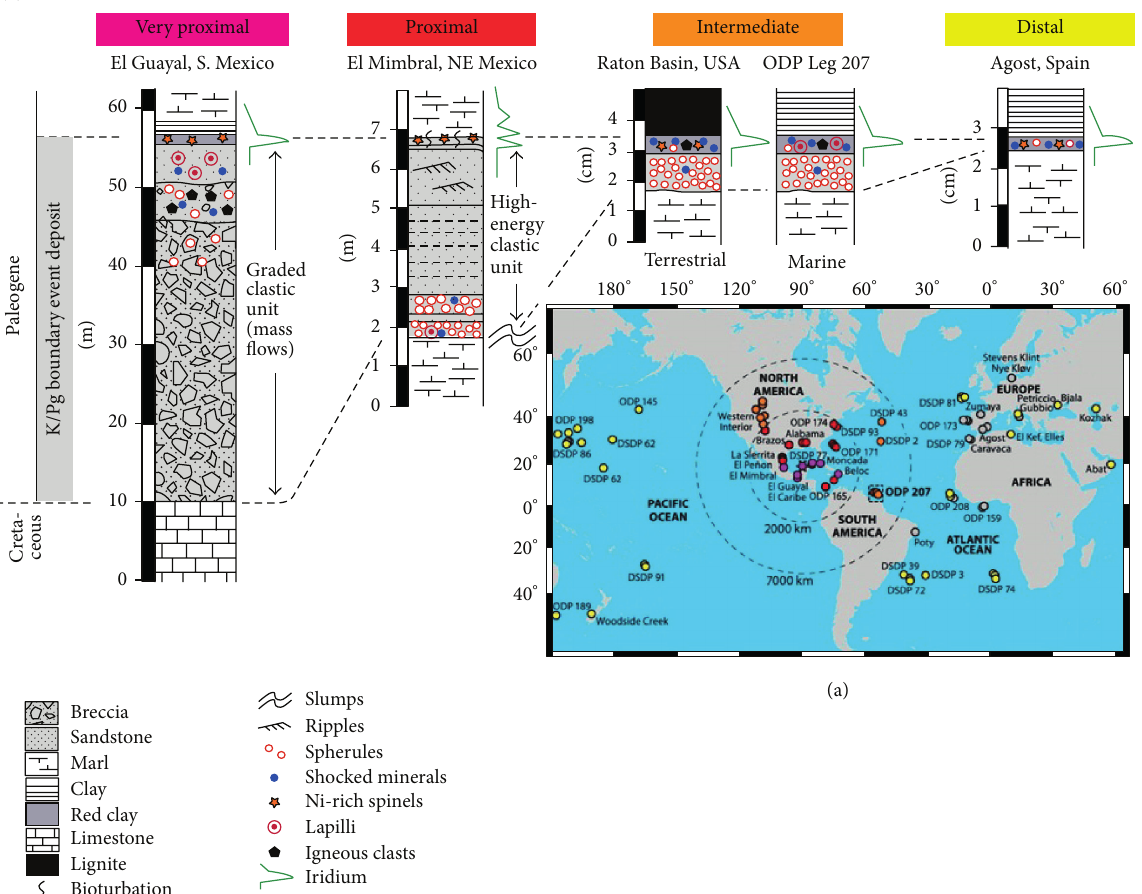
Figure 6: Cretaceous/Paleogene (K/Pg) boundary sections for distal, intermediate, proximal, and very proximal sites. Schematic K/Pg boundary sections (b). (a) Distribution of K/Pg boundary sites (Schulte et al.